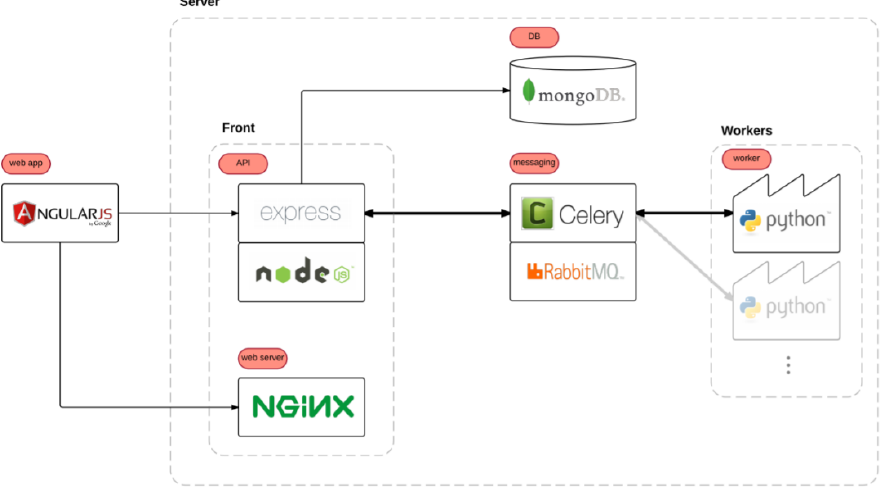
Figure 2. Architecture and technologies used in the web application developed for SimBPL.